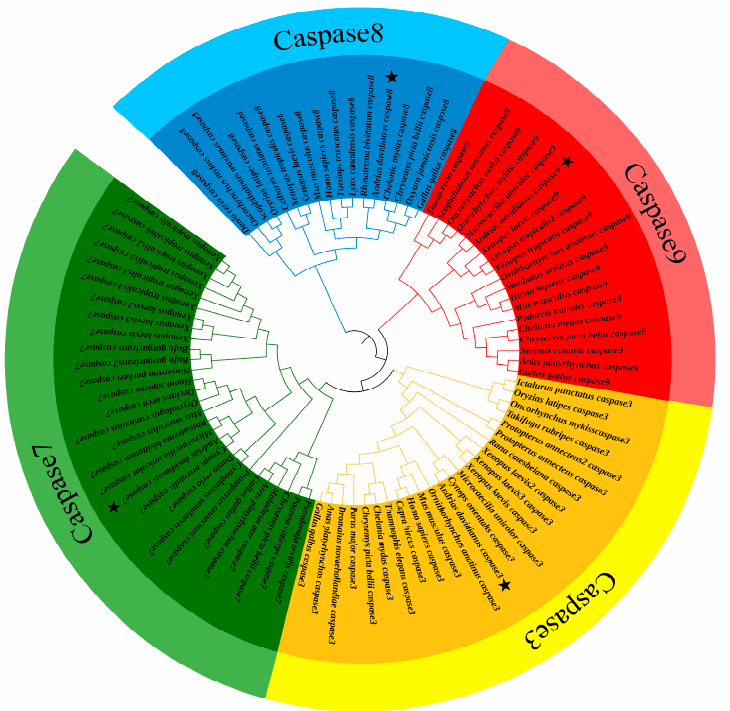
Figure 3. Phylogenetic tree of caspases 3/7/8/9 . Pentagrams represent the Chinese giant salamanders used in this study.